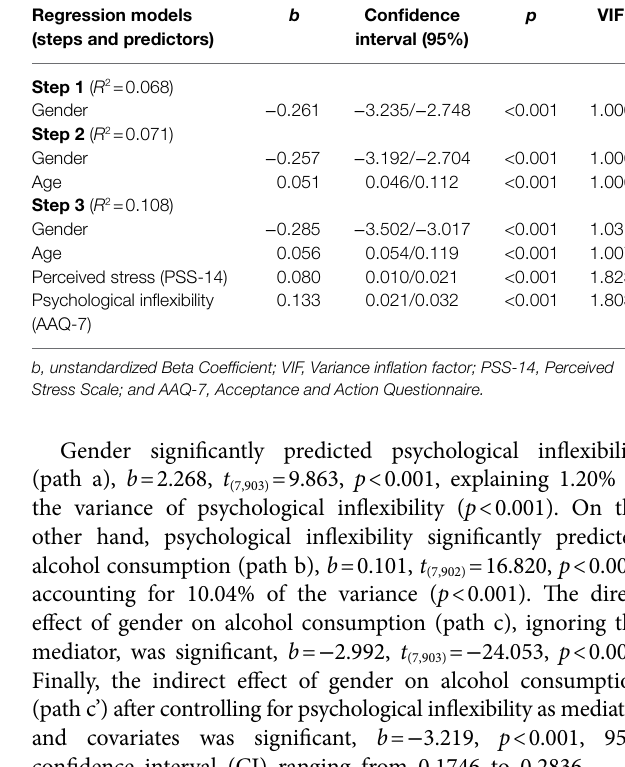
TABLE 3 | Hierarchical regressions examining the effect of perceived stress and psychological inflexibility on alcohol consumption. Regression models (steps and